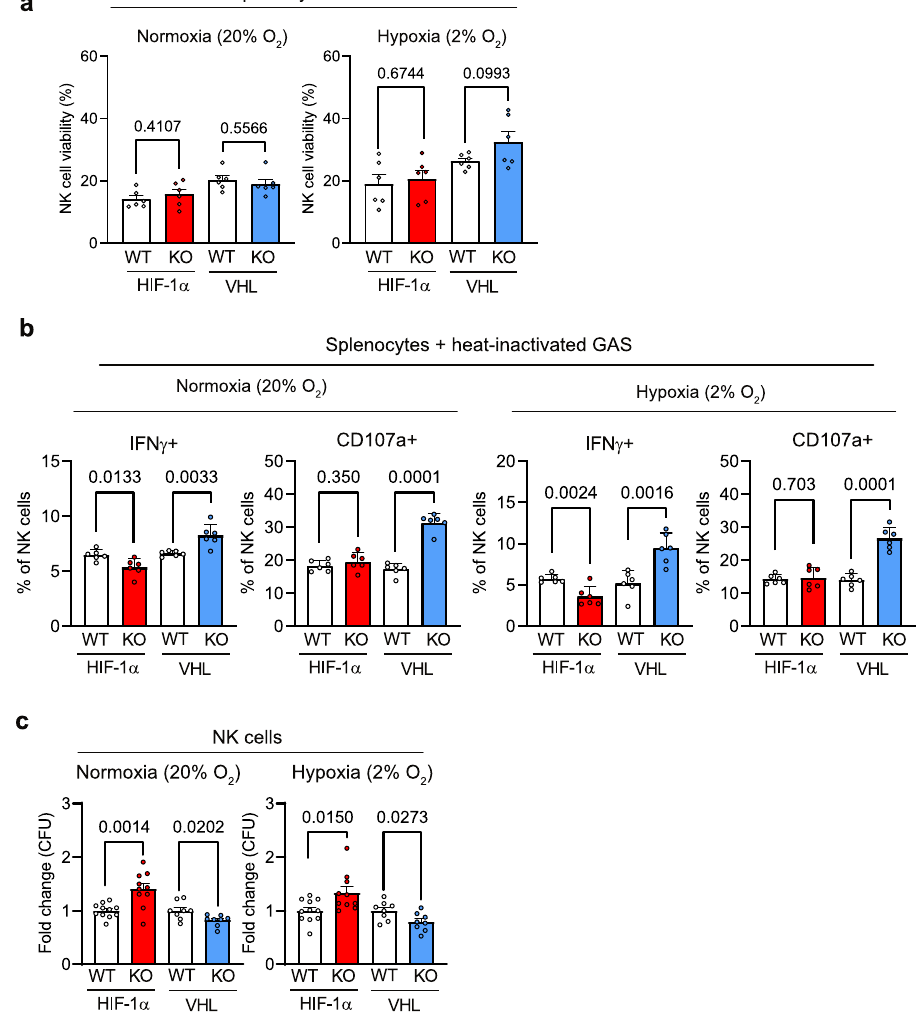
Fig. 7 NK cells contribute to bacterial killing in a HIF-1 α -dependent manner. a FACS analysis of NK cell viability after 4 h of coculture of splenocytes puri fi ed from HIF-1 α WT, HIF-1 α KO, VHL WT and VHL KO animals with GAS in normoxia (20% O 2 ) or hypoxia (2% O 2 ) relative to NK cell viability without GAS coculture, pooled data of 2, ( n = 6 mice). b FACS analysis of NK cell (NKp46 + , NK1.1 + ) activation (IFN γ + and CD107a + ) in splenocytes from HIF-1 α WT, HIF-1 α KO, VHL WT and VHL KO animals after stimulation with heat-inactivated GAS (hi GAS) for 6 h under normoxia (20% O 2 ) and hypoxia (2% O 2 ) relative to culture without GAS, pool data of 2 experiments, ( n = 6). c Killing of GAS by puri fi ed splenic NK cells HIF-1 α WT, HIF-1 α KO, VHL WT and VHL KO. NK cells were cocultured with GAS at a multiplicity of infection (MOI) equal to 1 under normoxic (20% O 2 ) or hypoxic (2% O 2 ) conditions for 4 h. CFUs are represented as fold change relative to the corresponding WT NK cells, pooled data of 3 experiments, ( n = 11 for HIF-1 α WT, n = 10 HIF-1 α KO, n = 8 for VHL WT and n = 8 for VHL KO). Data are mean values± SEM, statistical analysis: two-tailed Student ’ s t